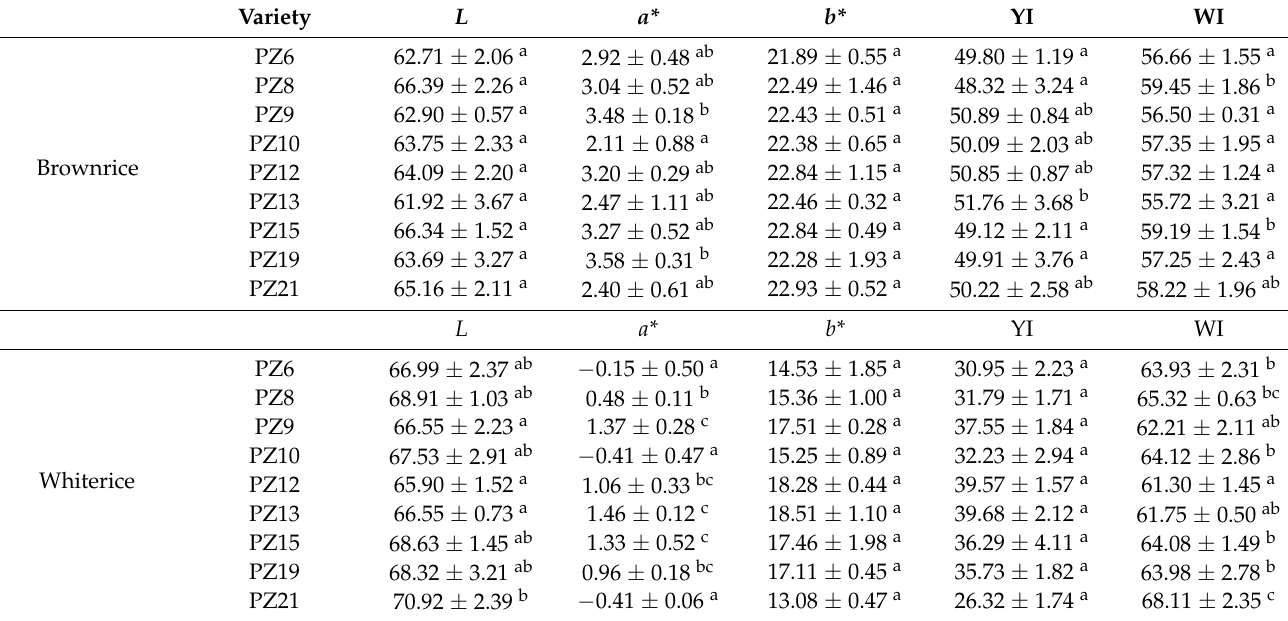
Table 2. Color analysis of different brown rice and white rice japonica variety.